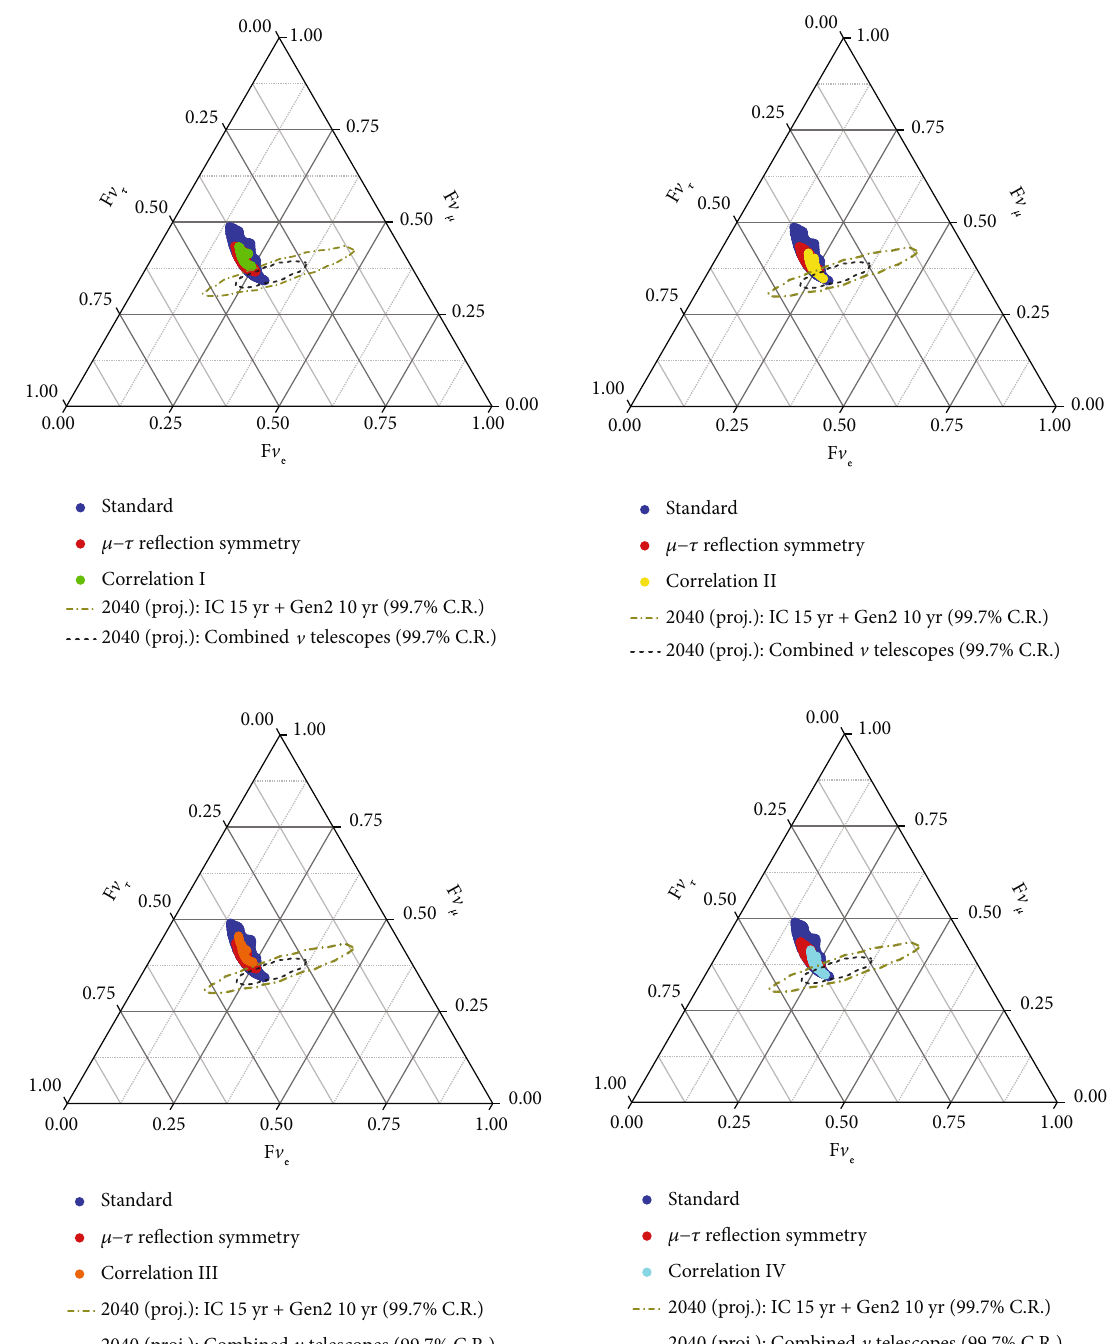
Figure 11: Ternary plot of the fl avor ratio at Earth with the muon-damping decay source. “ Standard ” denotes the fl avor ratio predicted with the leptonic mixing parameters at the 3 σ level of the global fi t data [43]. “ μ − τ re fl ection symmetry ” denotes the fl avor ! Þ − ! , τ 1 j < 0 : 001 to the “ standard ” case. The geometric constraints of correlations I-IV composition that adds a constrain of j cos ð μ are de fi ned in Table 5 and Equation (7). The 2040 3 σ credible region with the pion-decay source based on IceCube and IceCube- Gen2 is taken from Ref. [53]. The 3 σ credible region with the pion-decay source based on all TeV-PeV neutrino telescopes available in 2040 is taken from Ref.